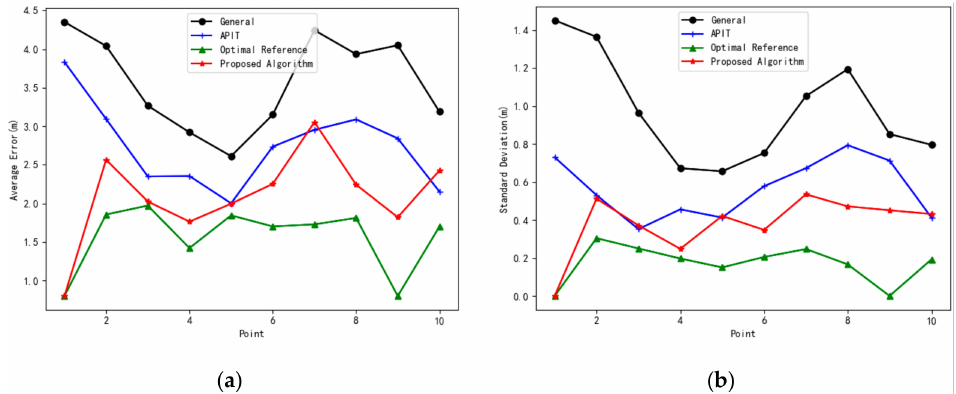
Figure 10. Average error and standard deviation of different methods. ( a ) Average error. ( b ) Standard deviation of error.